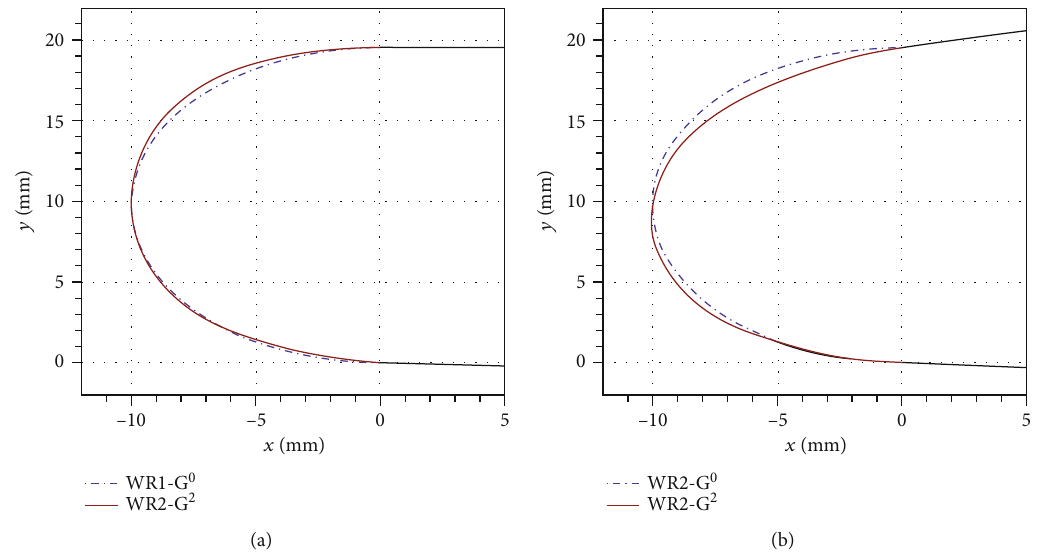
Figure 11: Blunting curves on the central plane of waveriders: (a) blunting curves from WR1-G 0 and WR1-G 2 ; (b) blunting curves from WR2-G 0 and WR2-G 2 . Table 5: Overall aerodynamic performances of the blunted waveriders.